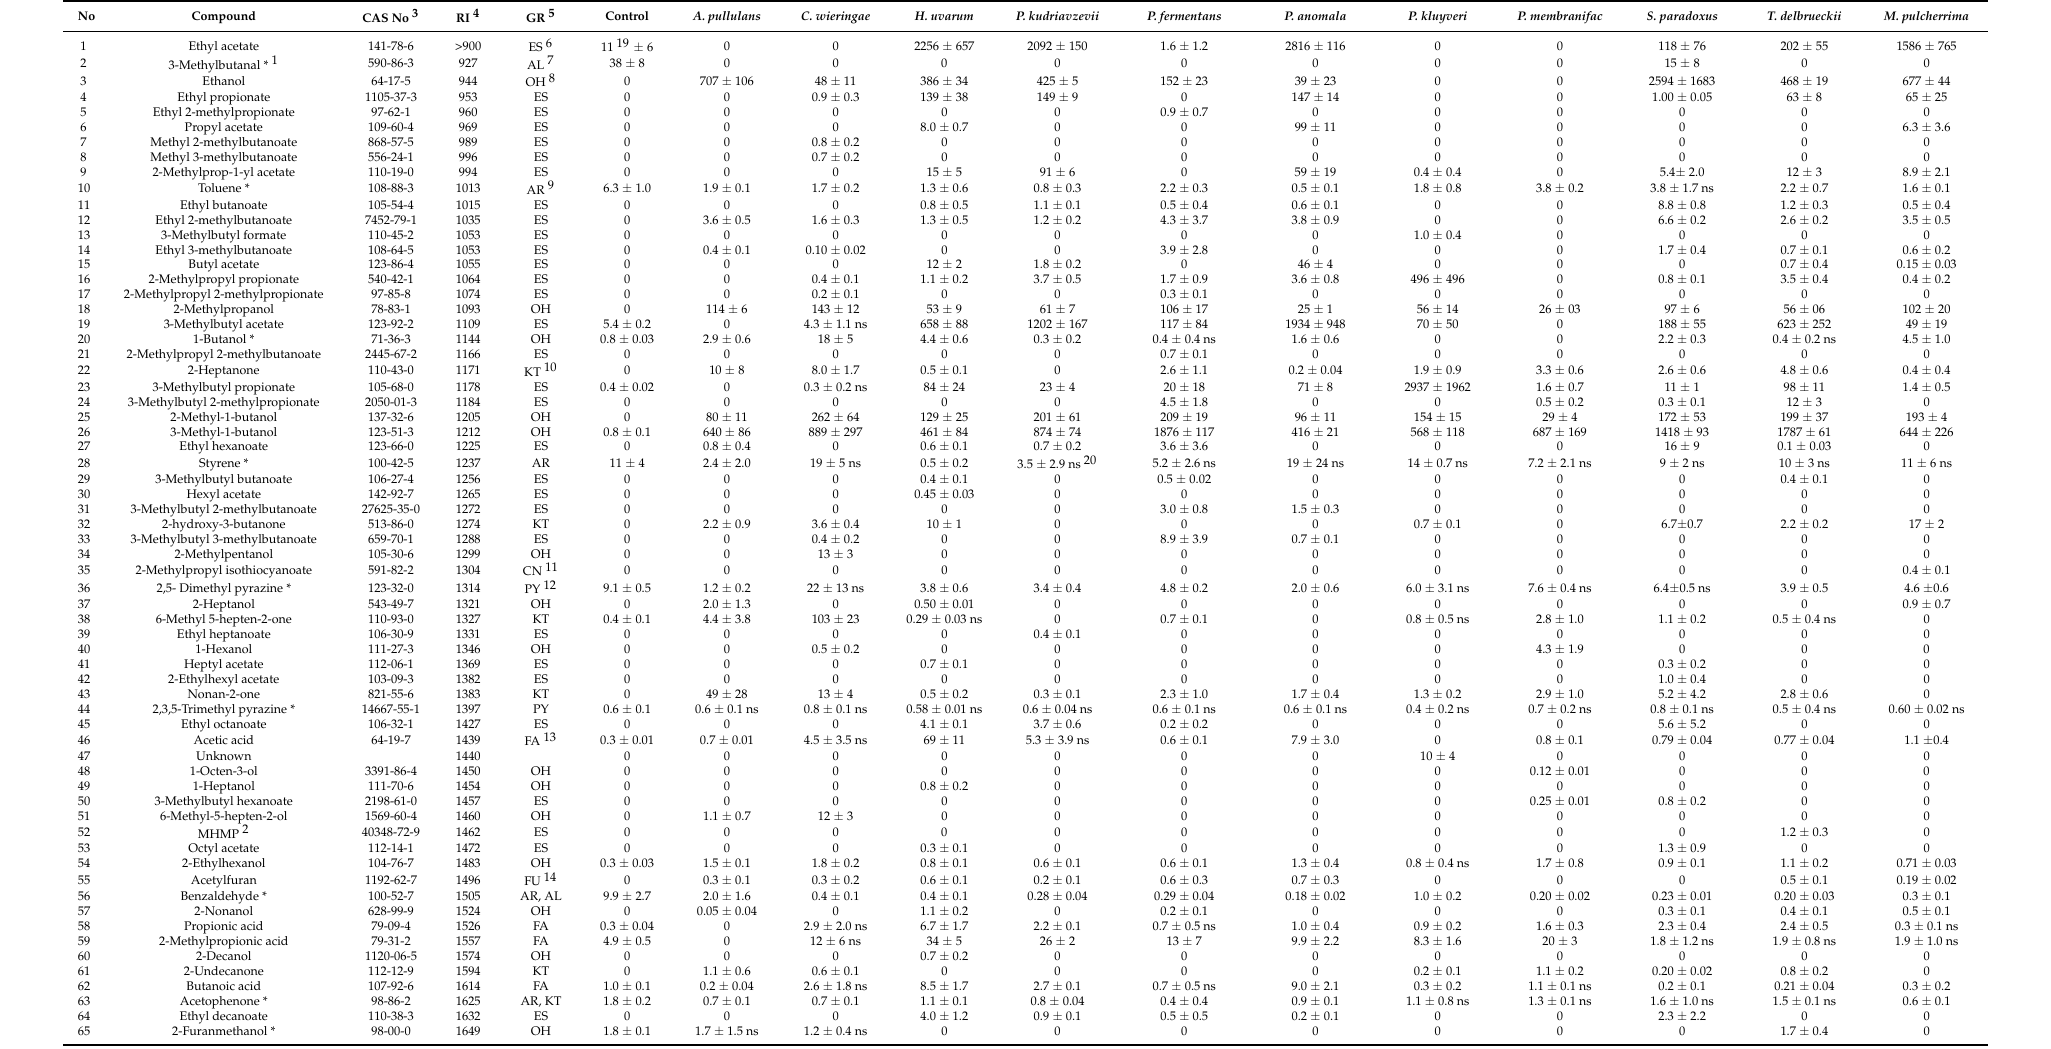
Table 1. Odour blends of eleven yeast species and controls sampled from a headspace by the SPME